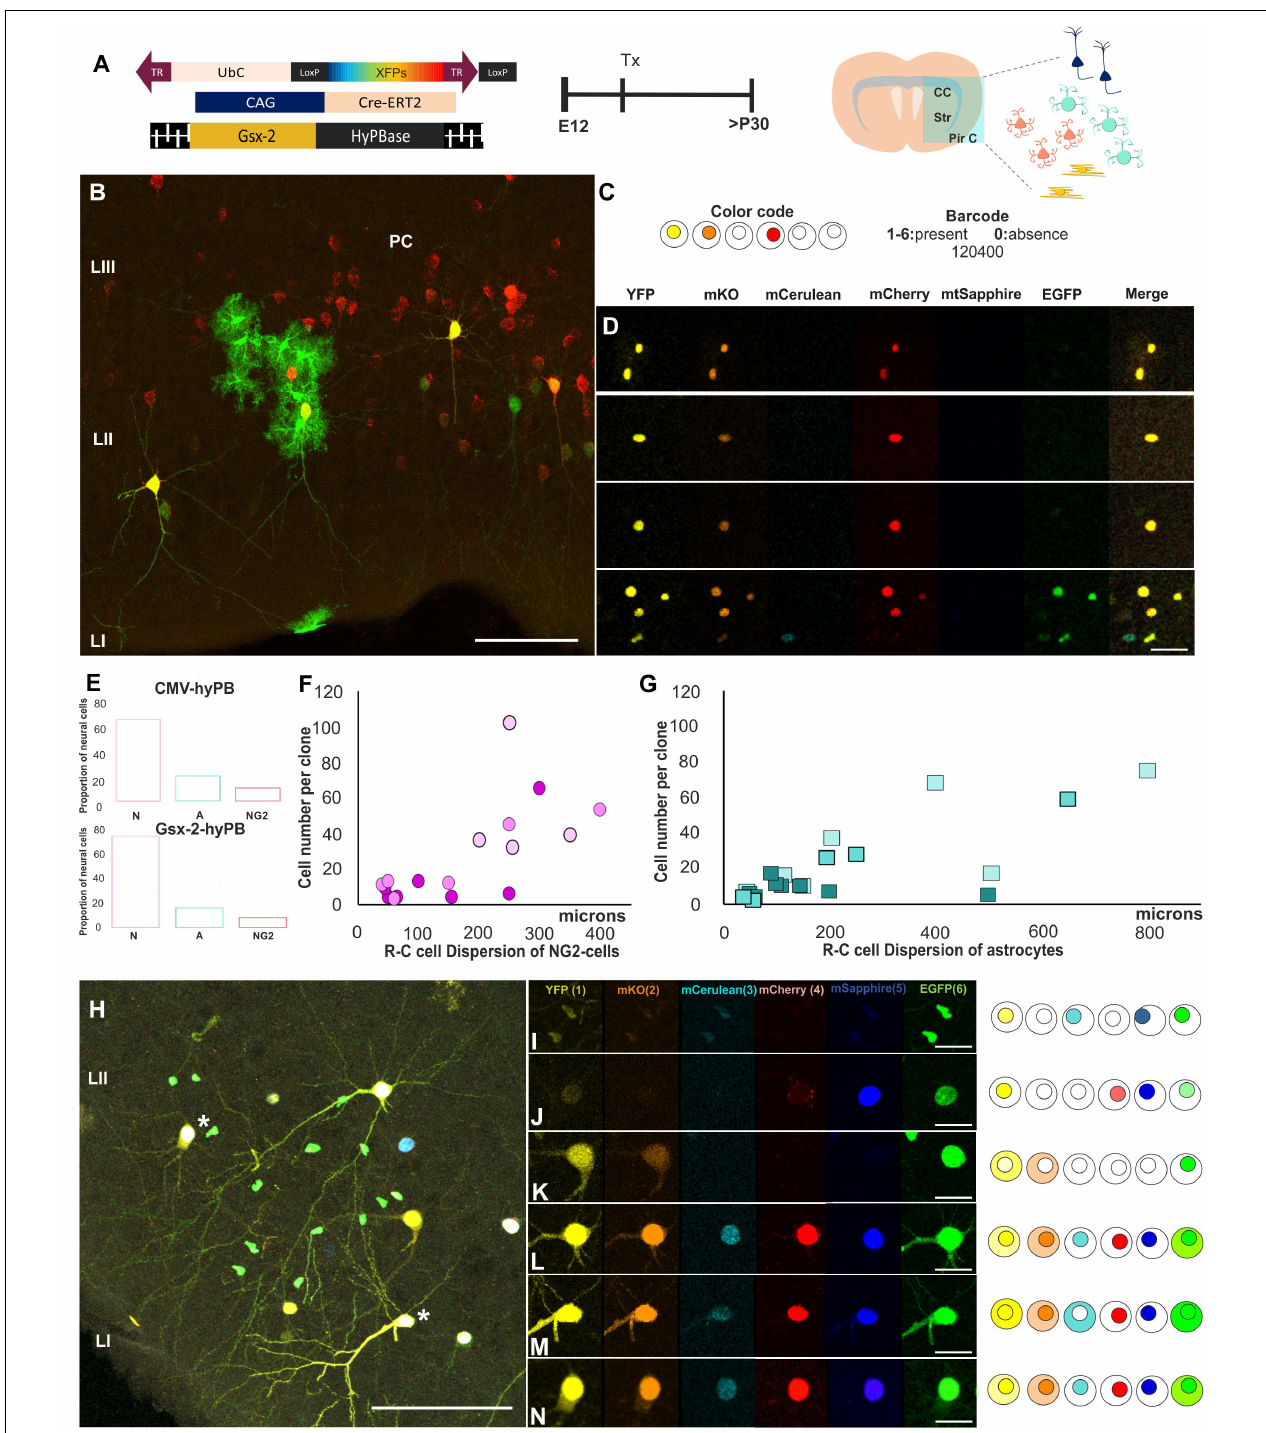
FIGURE 4 | Clonal analysis of the progeny derived from single subpallial progenitors. (A) Diagram of the UbC-StarTrack approach. (B–D) StarTrack labeled cells located in the PC and their clonal timeline. The color code of sibling cells located in the PC were analyzed by the presence (1–6) or absence of the reporter proteins. (E) The proportion of glial cells using both UbC-StarTrack approaches show similar proportion of both astrocytes and NG2 cells. (F,G) Sibling NG2-glia cells dispersed less than astrocytes in the PC ( y -axis), but the number of cells per clone was higher ( x -axis) than astrocytes. (H) Neural cells were localized along the PC in different layers and with different morphologies. Different barcodes of these neural cells are detailed from panels (I–N) , where neurons L and N share the same reporter protein combination concluding that they derived from the same E12-progenitor cell. NG2 cells are in pink and astrocytes in blue. N, neuron; A, astrocytes; PC, piriform cortex; R-C, rostro-caudal; Tx, tamoxifen. Scale bar: 50 µ m (B,H) and 25 µ m (D,I–N) .